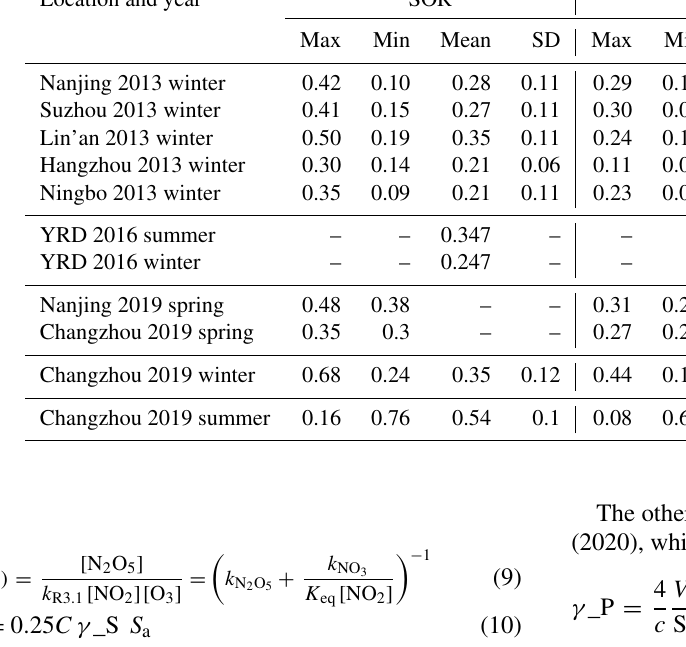
Figure 4. (a) Particulate ion mass concentration ratio of nitrate and sulfate to water-soluble ion. (b) NOR against RH, colored with temper- ature. (c) SOR against RH, colored with temperature. Table 2. Statistical result of NOR and SOR in the YRD. Location and year SOR